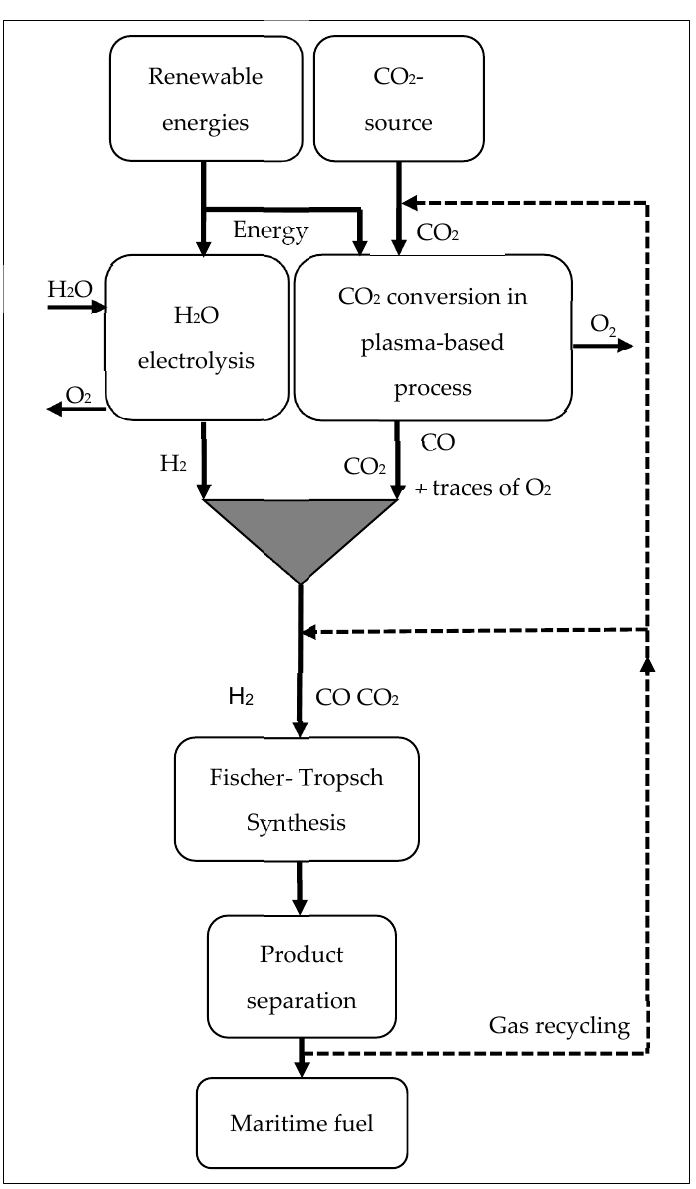
Figure 1. CO 2 capture and usage in Fischer-Tropsch Synthesis to produce maritime fuel.